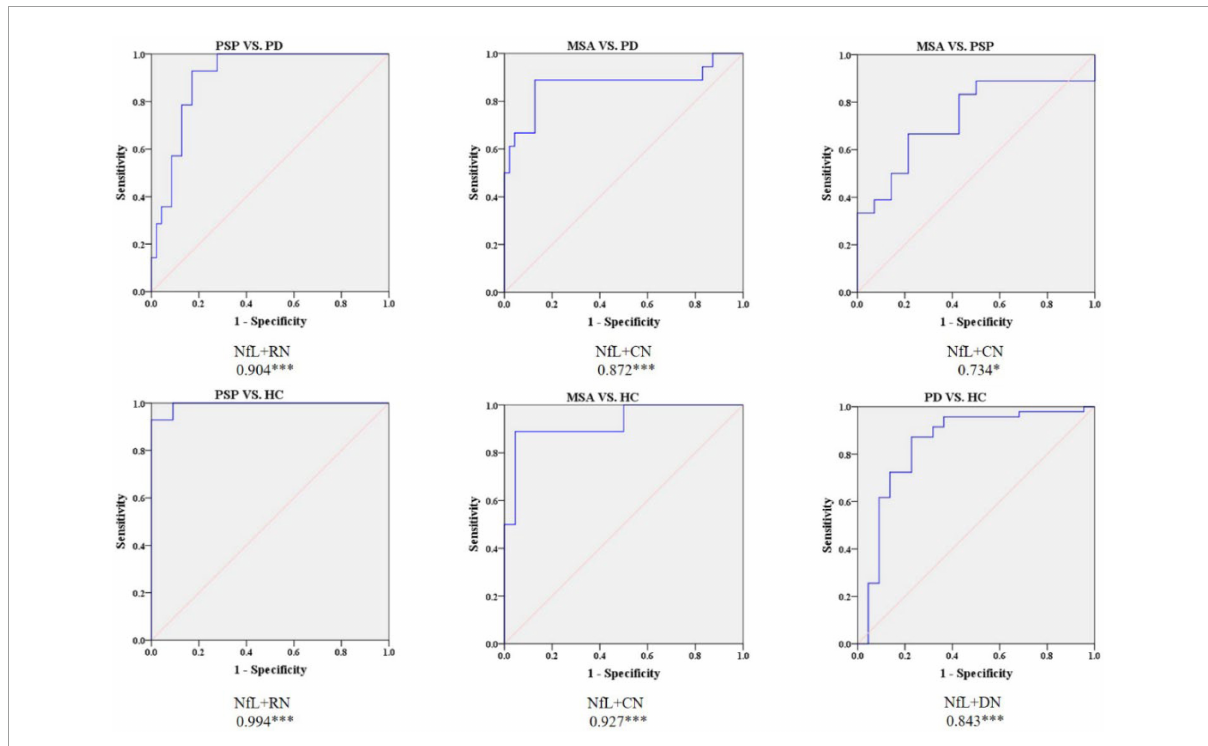
FIGURE6 Receiver operating characteristic (ROC) curves showing comparisons in combining QSM and plasma NfL between parkinsonian disorders and HC. ∗ P < 0.05, ∗∗∗ P ≤ 0.001. HC, healthy control; PD, Parkinson’s disease; PSP, progressive supranuclear palsy; MSA, multiple system